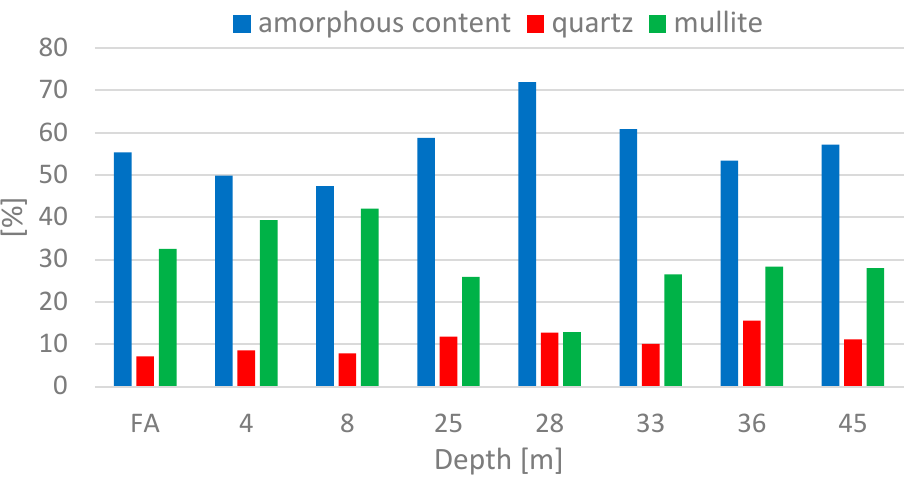
Figure 5. Representation of Major Phases Obtained by XRD for Fresh Fly Ash and Deposited Ash at Selected Depths from V3. Measurement errors were below 3 wt%.